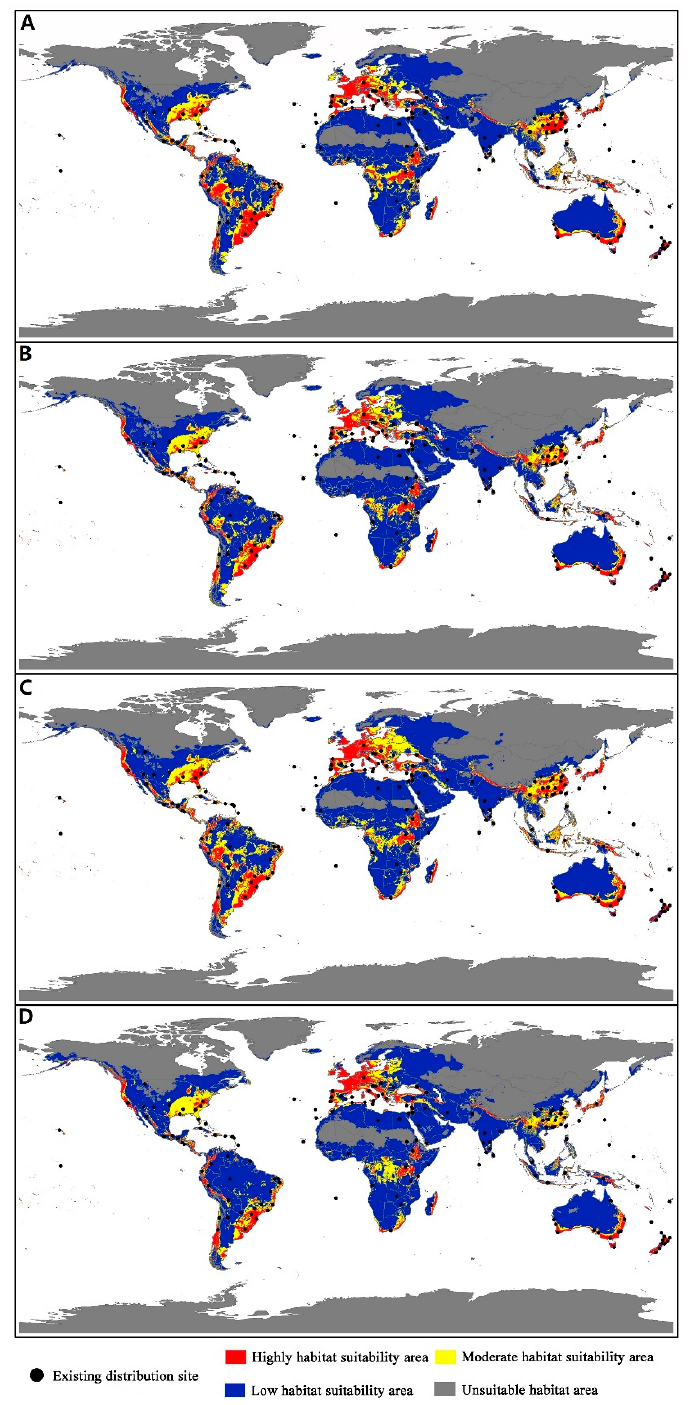
Figure 10. Future species distribution models of Icerya purchasi on global scale under different climate scenarios predicted by MaxEnt. ( A ) 2050RCP4.5; ( B ) 2050RCP8.5; ( C ) 2070RCP4.5; ( D ) 2070RCP8.